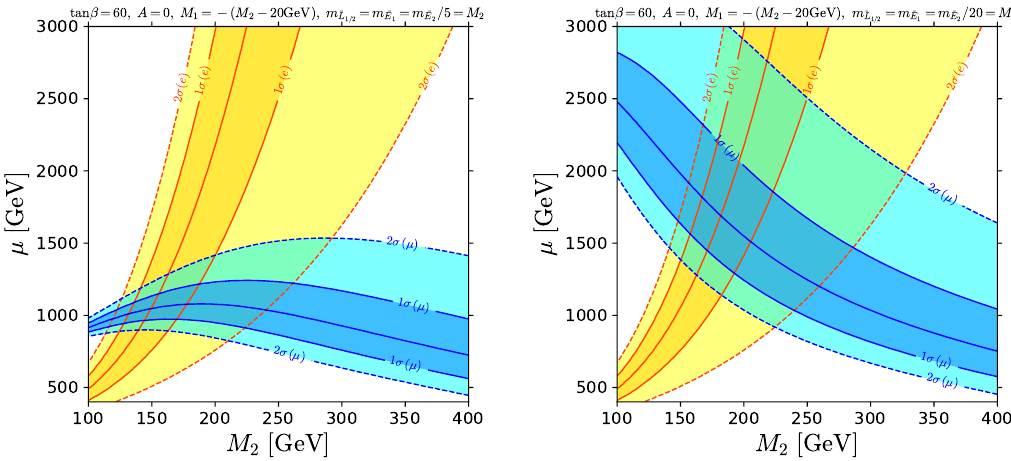
Figure 2 . Contours of SUSY contribution to electron (yellow) and muon (blue) g (cid:0) 2 in the plane of (cid:22) and M 2 = m ~ = m ~ = m ~ for tan (cid:12) = 60 and M 1 = (cid:0) ( M 2 (cid:0) 20 GeV). In the left (right) E 1 L 1 L 2 plot m ~ (cid:22) is 5 (20) times larger than M 2 and the other sleptons. R